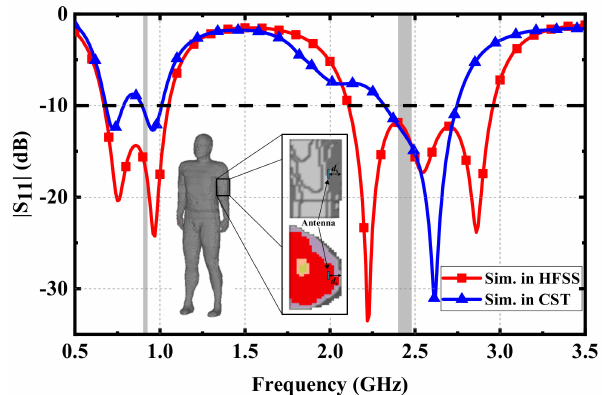
Figure 9. Comparison of the simulated |S 11 | in the three-layer phantom of HFSS and the Hugo phantom of CST.